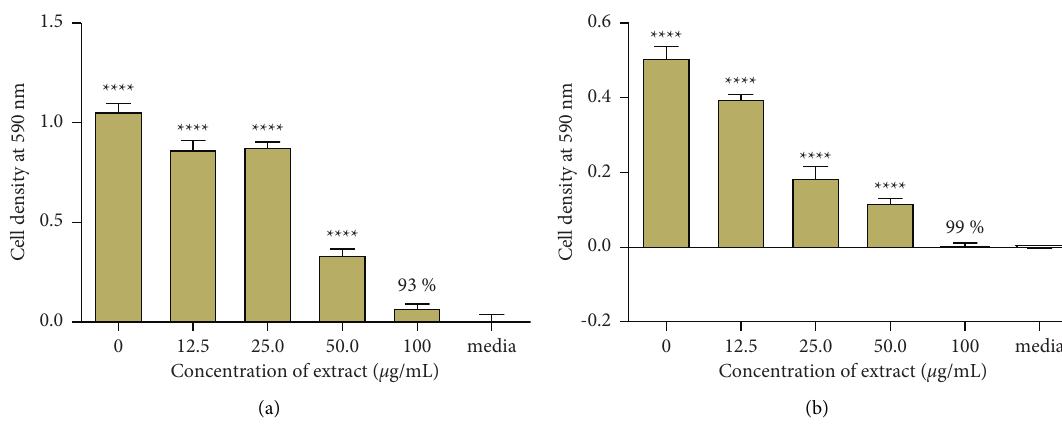
Figure 1: Antibacterial effects of O. reticulata root bark extracts against S. aureus. The data are obtained by incubating S. aureus cells in the presence of (a) DCM extract and (b) ethyl acetate extract. All values are expressed as the mean ± SD of four replicates. Statistical one-way ANOVA and Bonferroni’s multiple comparison test (where ∗ < 0 . 05, ∗∗ < 0 . 01, ∗∗∗ < 0 . 001, ns � no significant difference vs. media) show that there is no significant difference between media and cells exposed to 100 µ g/mL of ethyl acetate extract. The percentage inhibitions of growth of S. aureus by the DCM and ethyl acetate extracts were 93 and 99%, respectively.